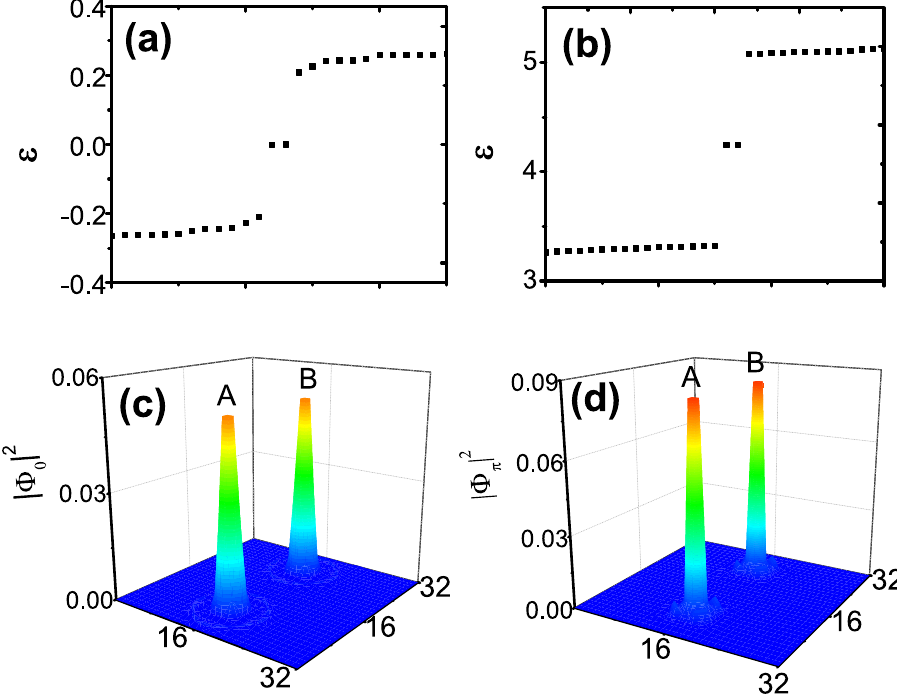
Figure 3. ( a ) and ( b ) are the quasienergies around ε 0, π respectively of the driven system with parameters as Fig. 1(d). The two pairs inner gap quasienergies ε 0, π are the quasienergies the two types Floquet Majorana zero modes. ( c ) and ( d ) are the wave functions of two types Floquet Majorana zero modes (| Φ 0, π | 2 ) of the system. The two types Floquet Majorana zero modes are localized at the ‘flux’